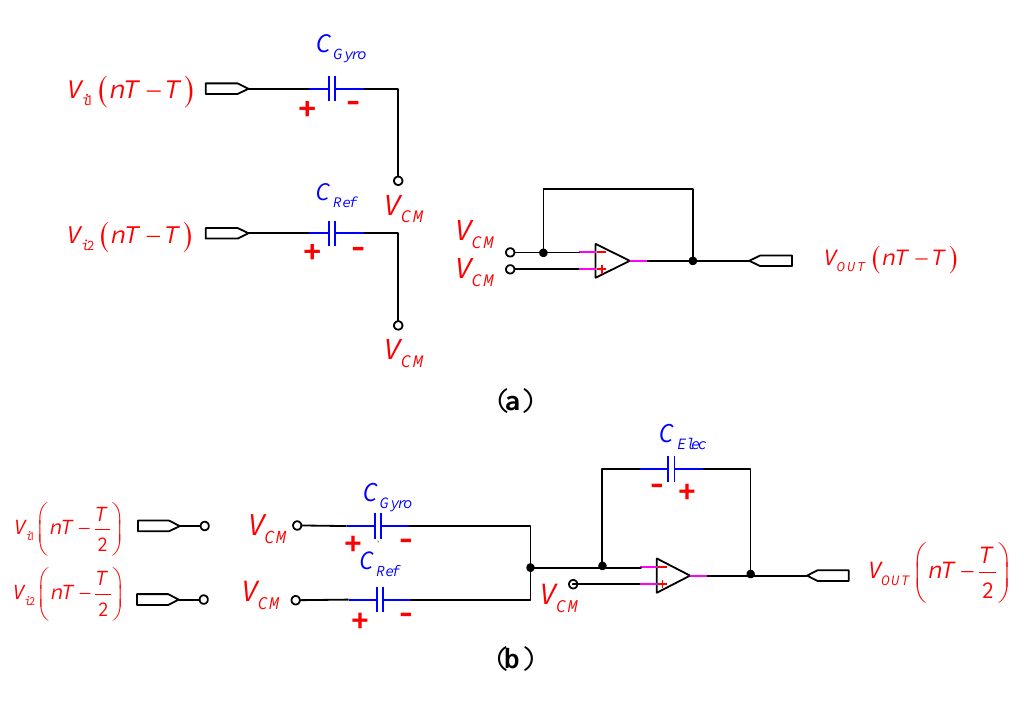
Figure 2. The PISC sensing circuit for the two operations: ( a ) sampling mode; ( b ) amplification